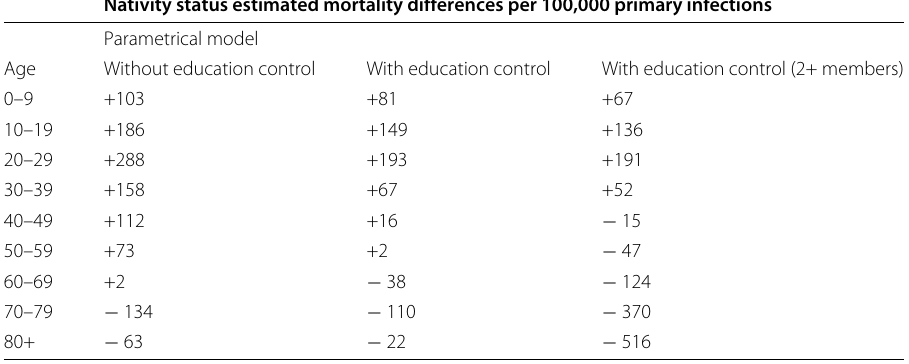
Table 16 Parametric estimates results of COVID-19 mortality inequalities (head-of-household nativity status